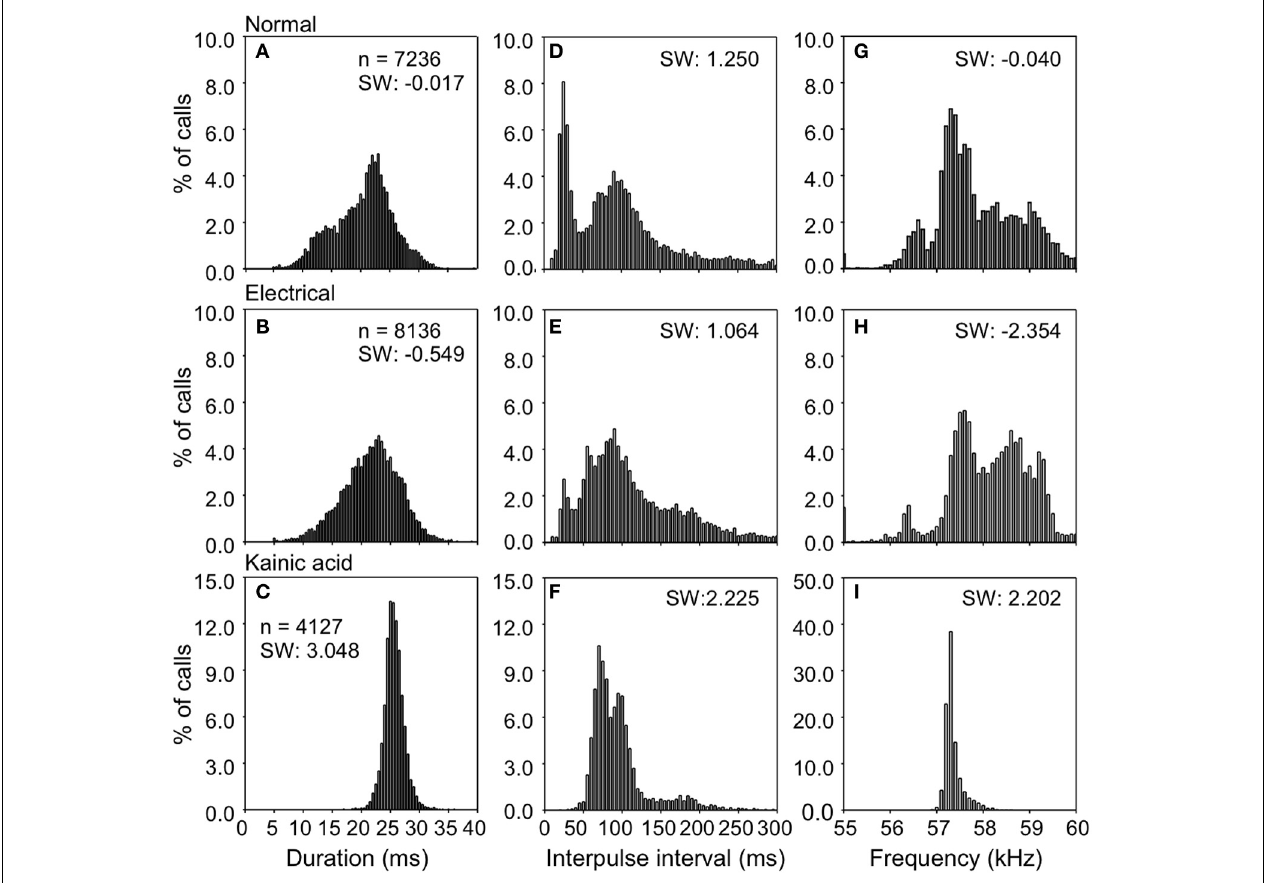
FIGURE 3 | Density plots showing the distributions for duration, interpulse intervals, and frequency of echolocation pulses elicited after electrical and KA stimulation. Data were obtained